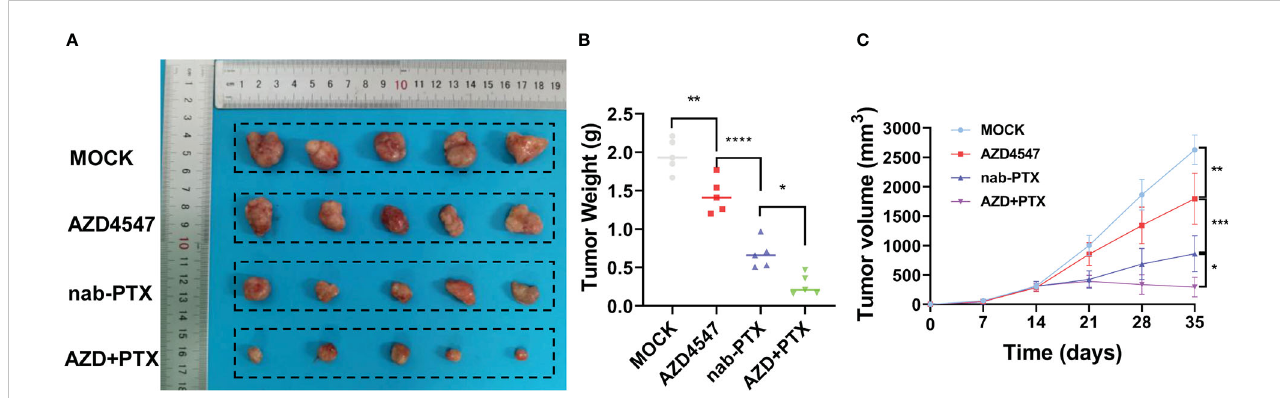
FIGURE 2 AZD4547 combined with nab-PTX exerted a synergistic antitumor effect in vivo . (A) Representative images of xenograft tumors formed by PC9 cells in nude mice. (B) The tumors were excised and weighed. (C) Cells were subcutaneously injected into nude mice, and tumor growth was assessed every week. *: p< 0.05, **: p< 0.01, ***: p< 0.001, ****: p<